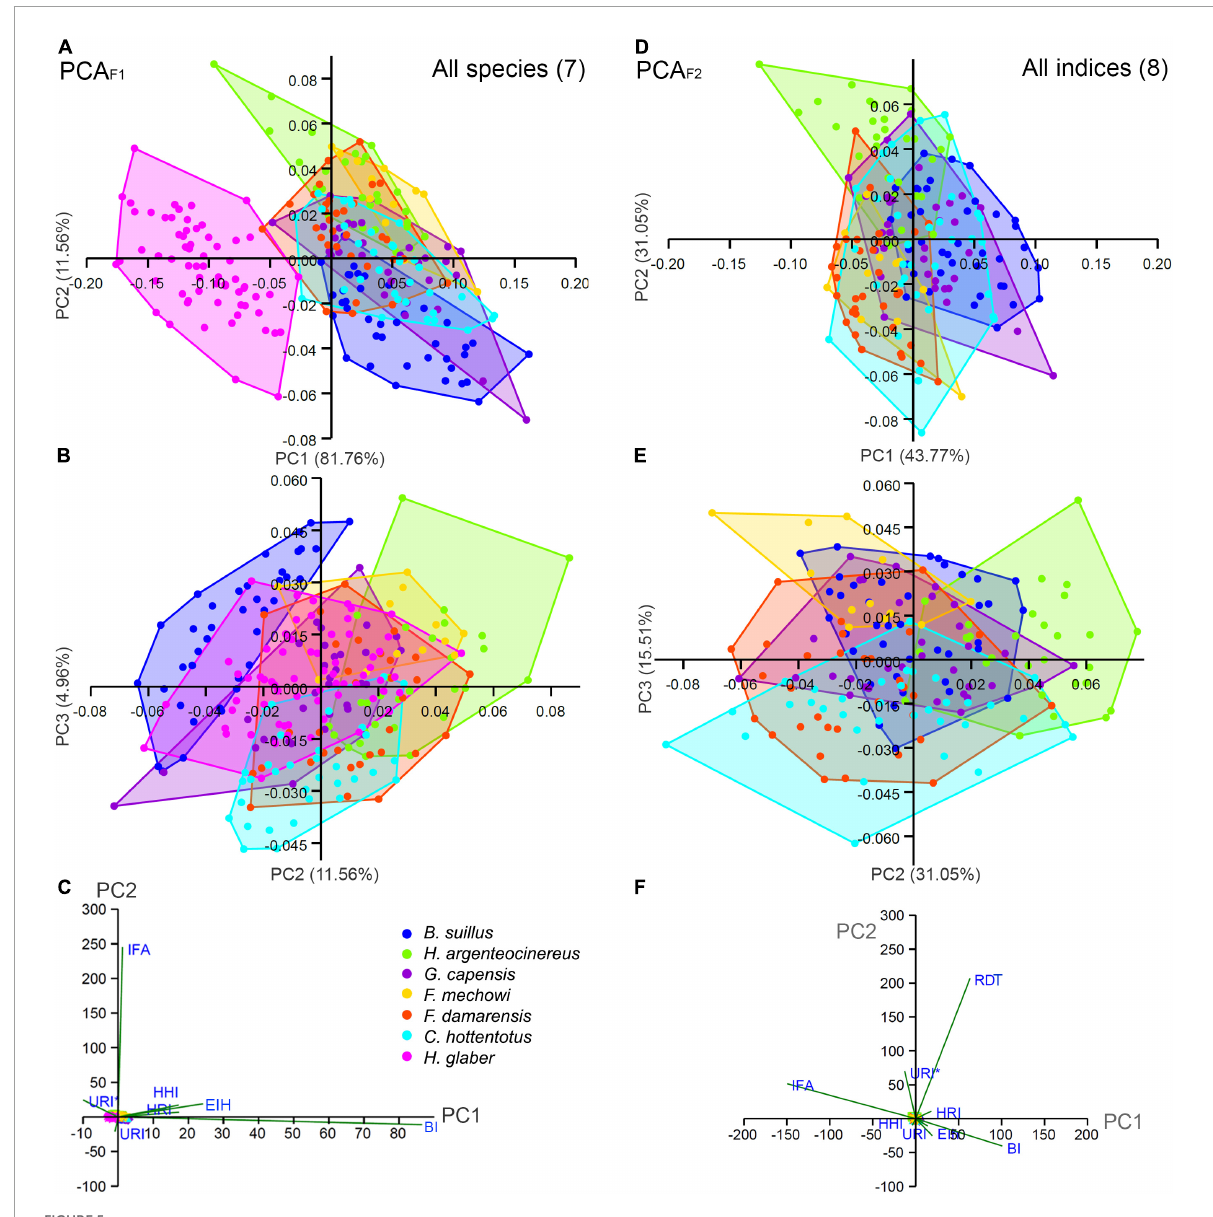
FIGURE5 Ordination analysis for the morpho-functional indices of the forelimb including all species (PCA F1 ) and all indices (PCA F2 ). (A) Principal components (PC1 and PC2) of PCA F1 . (B) PC2 and PC3. (C) Biplots for PC1 and PC2. (D) PC1 and PC2 of PCA F2 . (E) PC2 and PC3. (F) Biplots for PC1 and